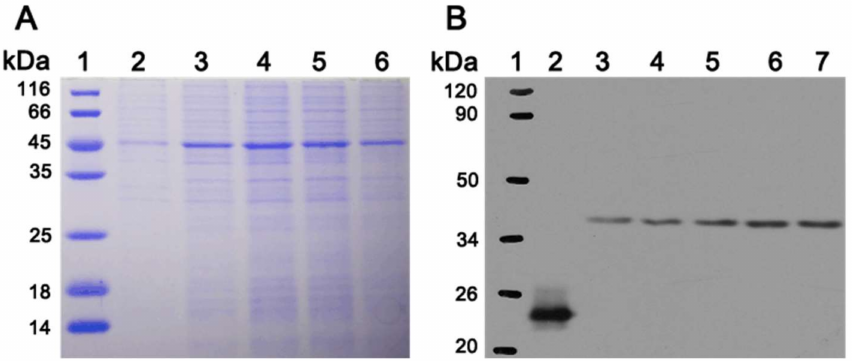
Figure 6. ( A ) The FAD8-1 protein was synthesized in vitro using the Expressway TM Mini Cell-Free Expression System. Products were loaded onto an SDS-PAGE gel and proteins were then visualized with Coomassie Blue staining. ( B ) Western Blot was also carried out and detected by his antibody. The exogenous positive control protein containing his tag at 23 kDa was used as a